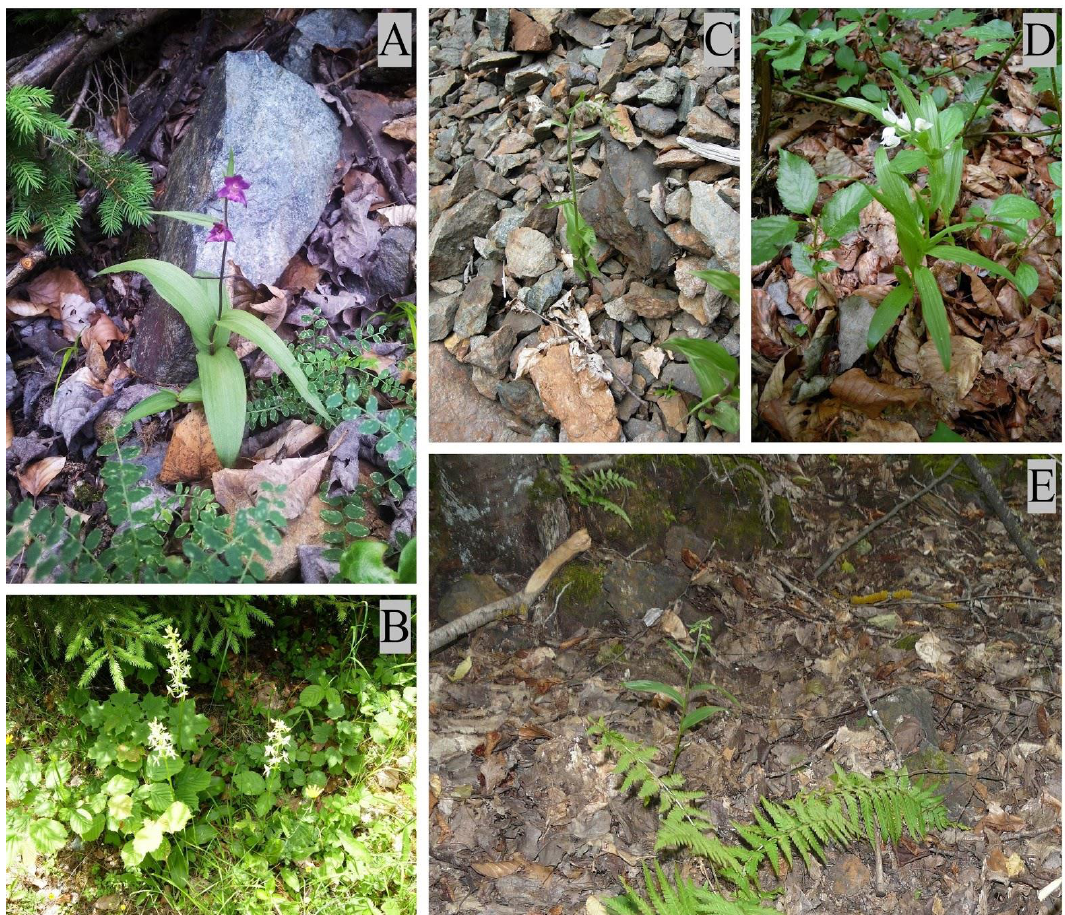
Figure 1. Unique species from the family Orchidaceae . E. atrorubens ( A ) and P. bifolia ( B ) from the Pb-Zn deposit Jasenie, E. atrorubens ( C ) from the Ni-Co deposit Dobšiná, C. longifolia ( D ) and E. pontica ( E ) from Fe deposit Sirk.